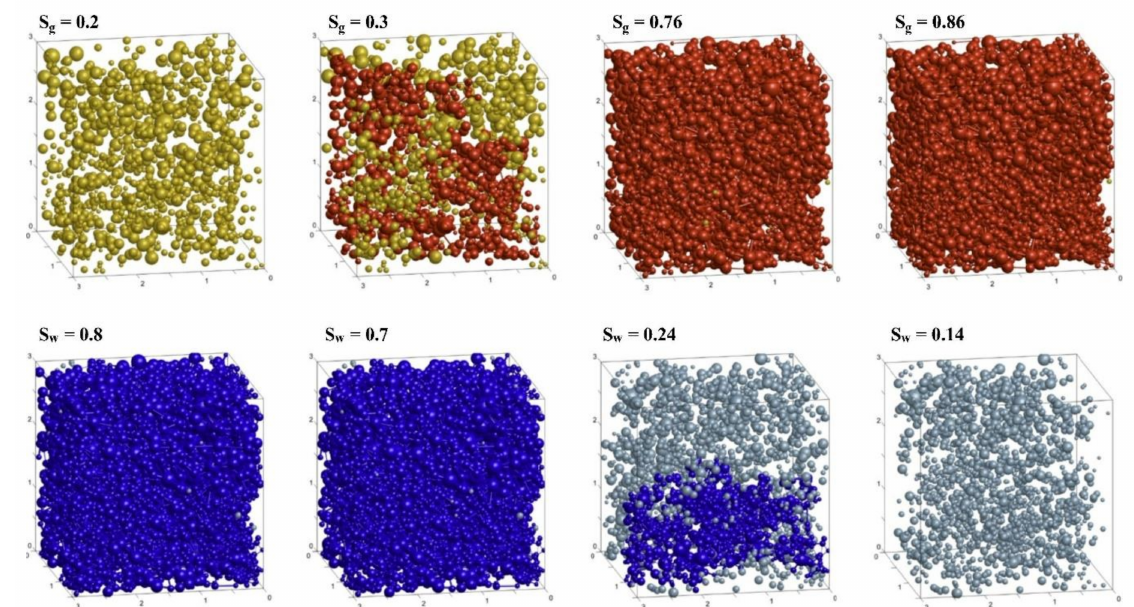
Figure 3. Illustrations of gas and water flow behavior during gas expansion in sediment hydrates under the dissociation process. The gas pores forming conductivity paths are represented in red, and the isolated gas pores are interpreted as yellow. Water pore forming conductivity paths are colored blue, and isolated water pores are colored light blue